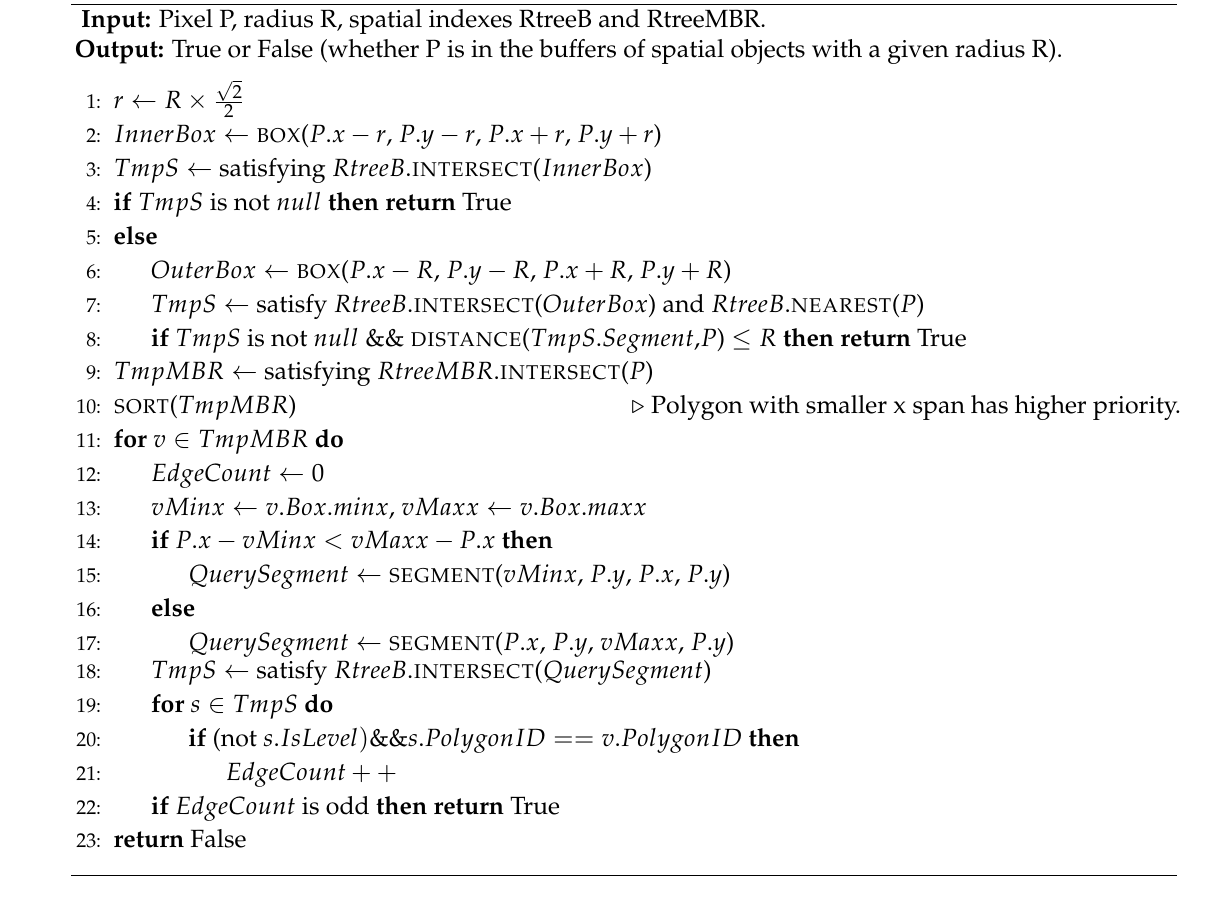
Algorithm 2 SIBBG for polygon